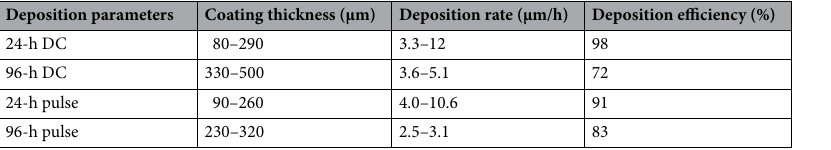
Table 1. Electrodeposition results.